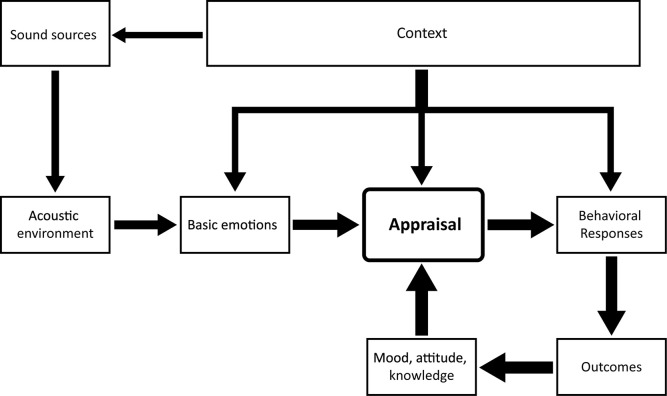
Conceptual framework of the emotional construct of soundscape [adapted from ISO 12913-1 (International Organization for Standardization, 2014)].